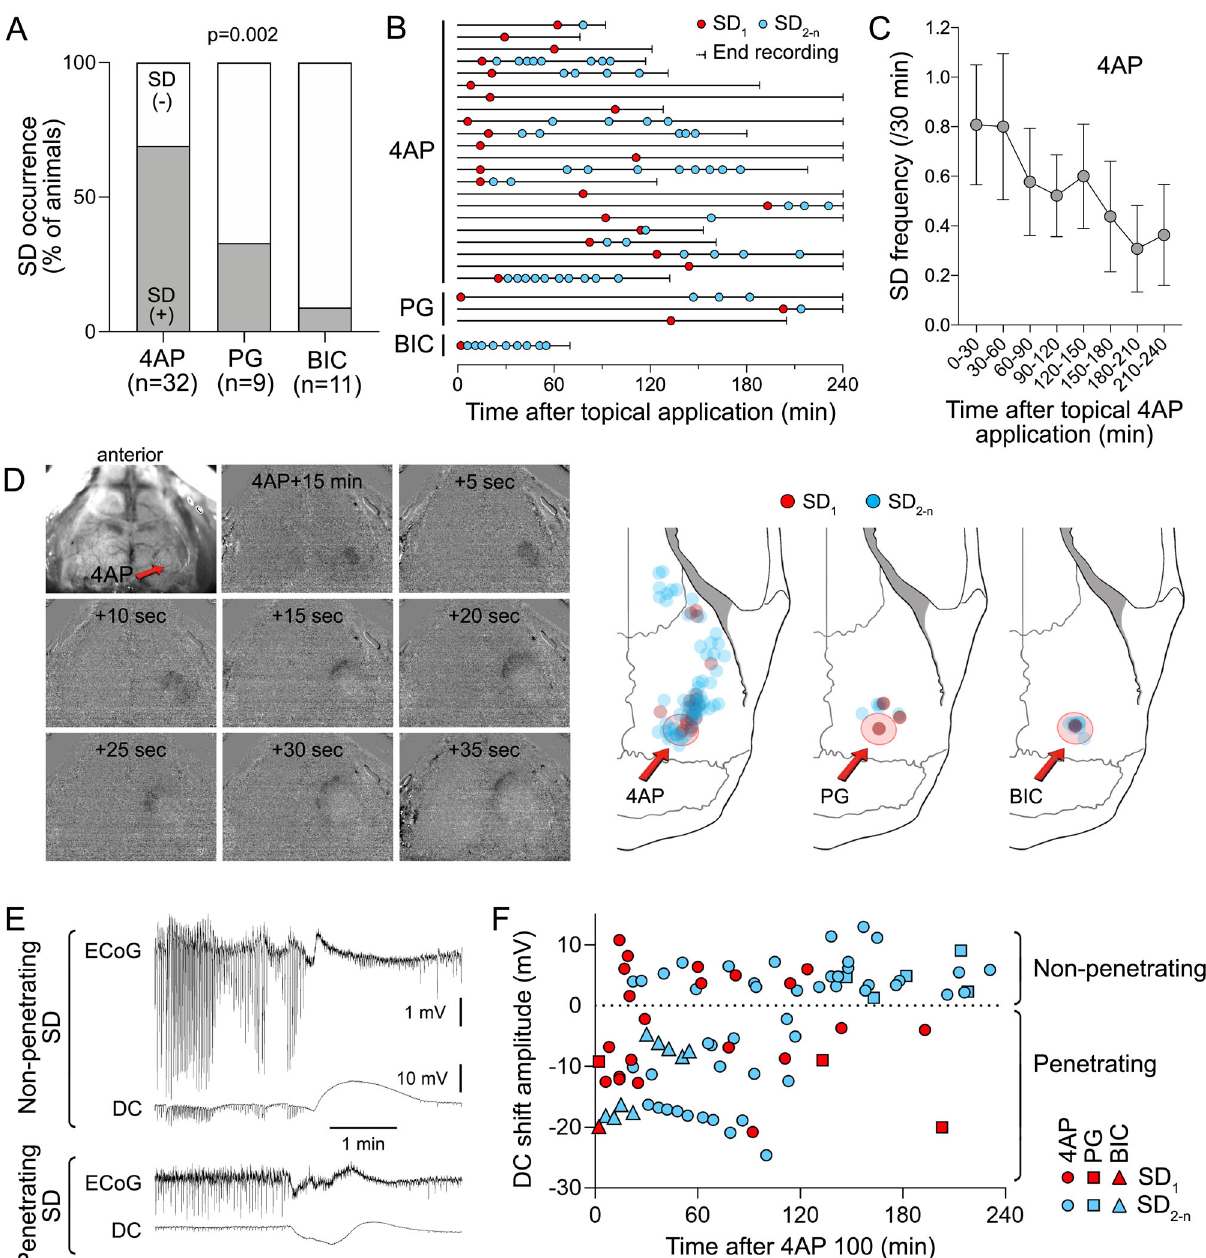
Fig. 3 Characteristics of SDs triggered by focal cortical seizures. A The proportion of animals developing SD with each epileptogenic agent ( p = 0.002; χ 2 ). Sample sizes are indicated below each bar. B Experimental timelines showing fi rst (SD 1 , red symbols) and subsequent SDs (SD 2-n , blue symbols). Each line represents the duration of recording in one experiment and each symbol represents one SD. Only experiments with at least one SD are shown. C The decrease in SD occurrence overtime after 4AP application (30-min bins) likely re fl ects weakening seizures (±SEM). D Time-lapse IOS subtraction images of an SD originating and spreading anteriorly 15 min after 4AP application (red arrow). The right panel shows the origins of the fi rst and subsequent SDs for each drug. Most SDs originated in the vicinity of the seizure focus. In 4AP seizures, subsequent SDs were more likely to erupt farther from the seizure focus, presumably due to generalization. E Representative ECoG and DC tracings of penetrating and non-penetrating SDs recorded by the epidural electrode over the seizure focus. Seizure-induced SDs were uncharacteristically variable in amplitude and duration. F The slow (DC) potential shift of the fi rst and subsequent SDs transformed from predominantly negative to predominantly positive over time as the seizure focus became more resistant to SD penetration. Each drug is represented by a different